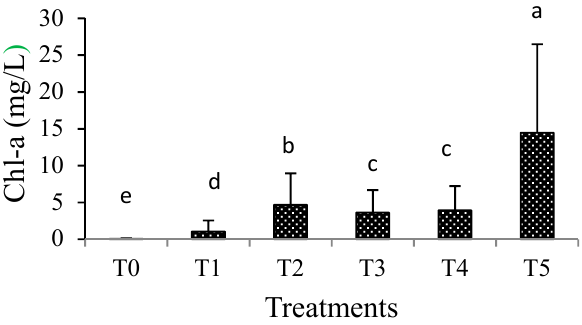
Figure 2. Mean concentrations of chlorophyll-a in different treatments: T 0 (the control), T 1 , T 2 , T 3 , T 4 , and T 5 correspond, respectively, to 0, 300, 600, 900, 1200, 1500 g of dry rabbit manure (RM).